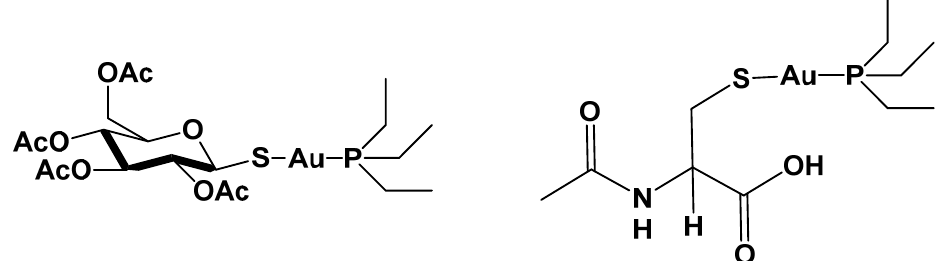
Figure 1. Chemical structure of Auranofin (AF, left ) and its analogue bearing L-Acetylcysteine in place of the thiosugar (AF-AcCys, right ).